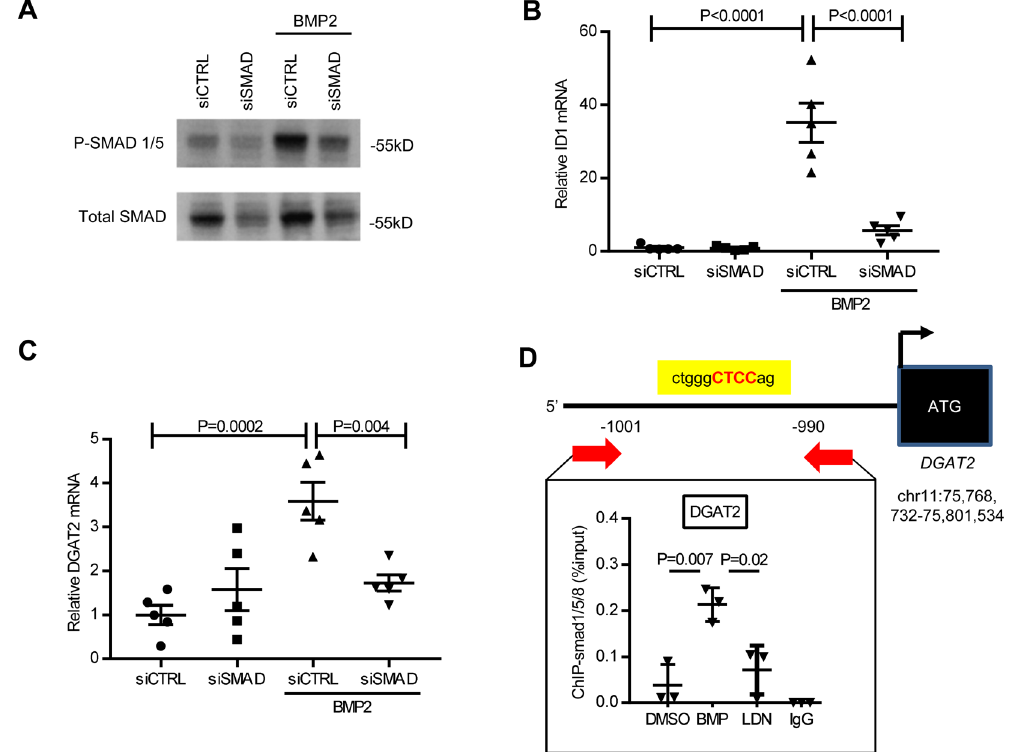
Figure 5. BMP-induced DGAT2 (diacylglycerol O-acyltransferase 2) expression is mediated through SMAD signaling. HepG2 cells treated with siRNA directed against SMAD 1/5 had reduced SMAD 1/5 protein levels ( A ) and decreased canonical BMP signaling as evidenced by decreased mRNA expression of ID1 (inhibitor of DNA binding 1) when stimulated with the BMP ligand BMP2 ( B ). BMP2-induced DGAT2 expression is SMAD1/5 dependent ( C ). Using chromatin immunoprecipitation combined with qPCR (ChIP-qPCR), BMP2 stimulation resulted in increased binding of SMAD 1/5 to a putative SMAD promoter region (1000 base pairs upstream of the DGAT2 start site) at 10-fold higher levels compared to control levels ( D ). Experiments had five replicates per group for panels ( B,C ) and three replicates per group for panel ( D ). SMAD western blots were run on 2 separate gels given similar protein weights. Comparisons were performed using 1-way ANOVA with Sidak’s multiple comparison